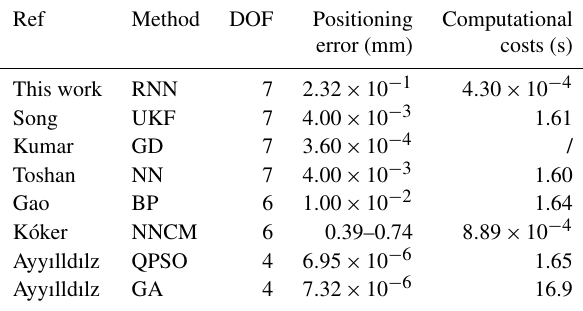
Table 7. Comparative study of the proposed method and similar